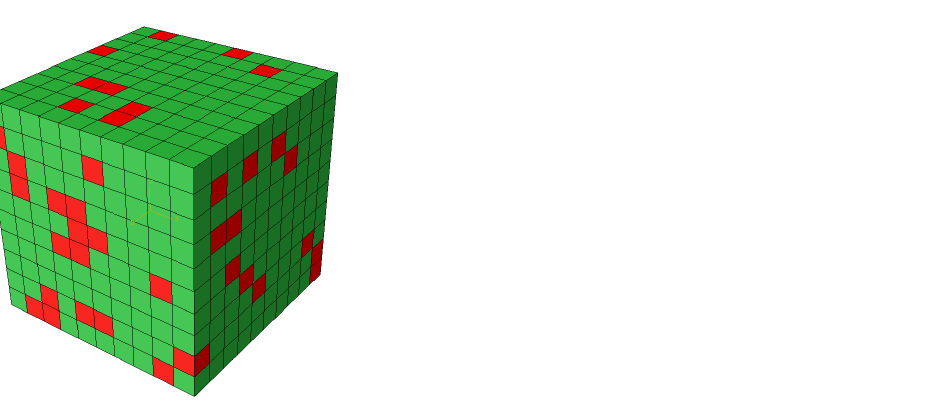
Figure 3. Example of a cubic model consisting of graphite (red) and BCC (green) grains used as Model 1 .